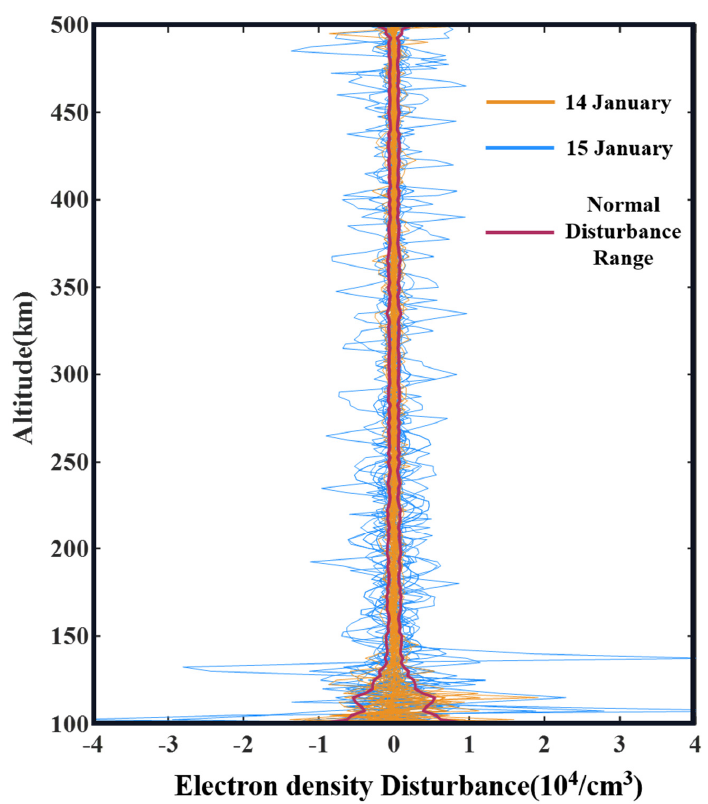
Figure 7. Comparison of the profile disturbance on 14 January and 15 January.